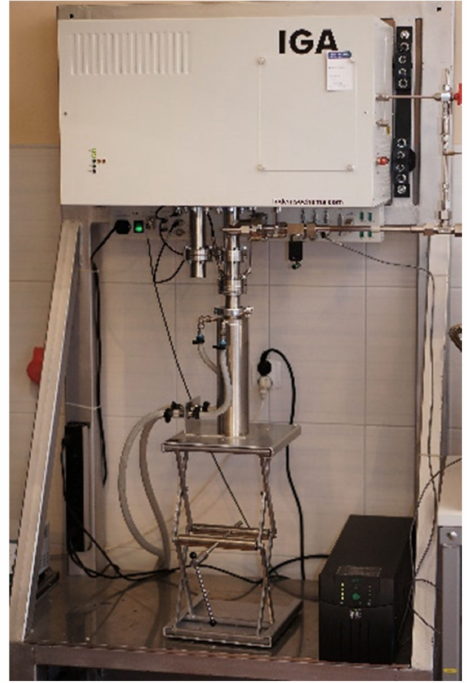
Figure 2. Gravimetric sorption analyser IGA-001: photo of the